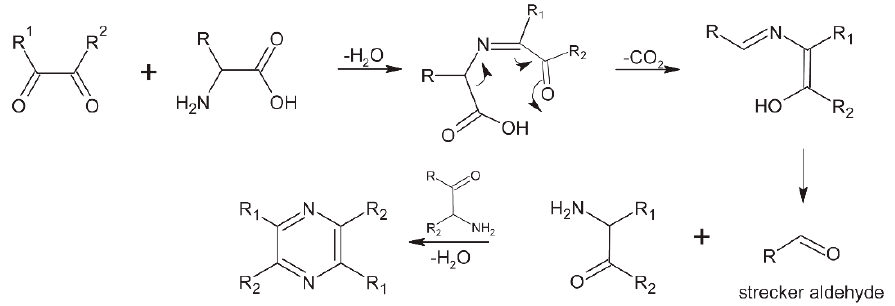
Figure 9. Production of pyrazine.